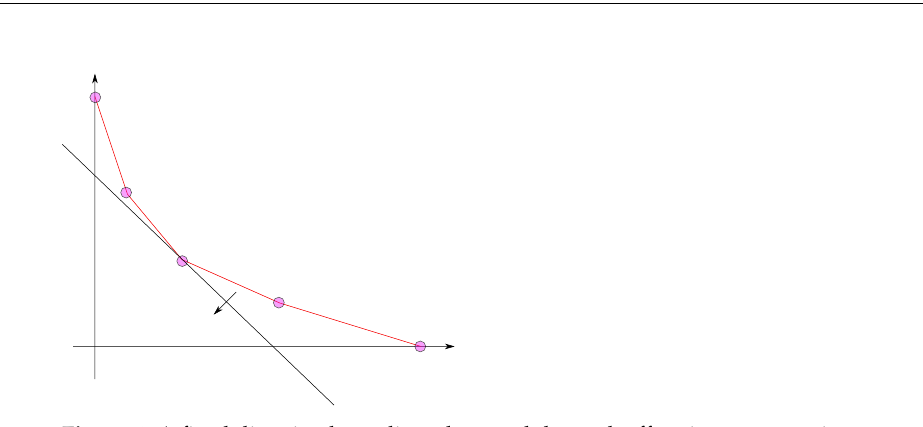
Figure 4. A fixed direction bounding plane and the tradeoff region